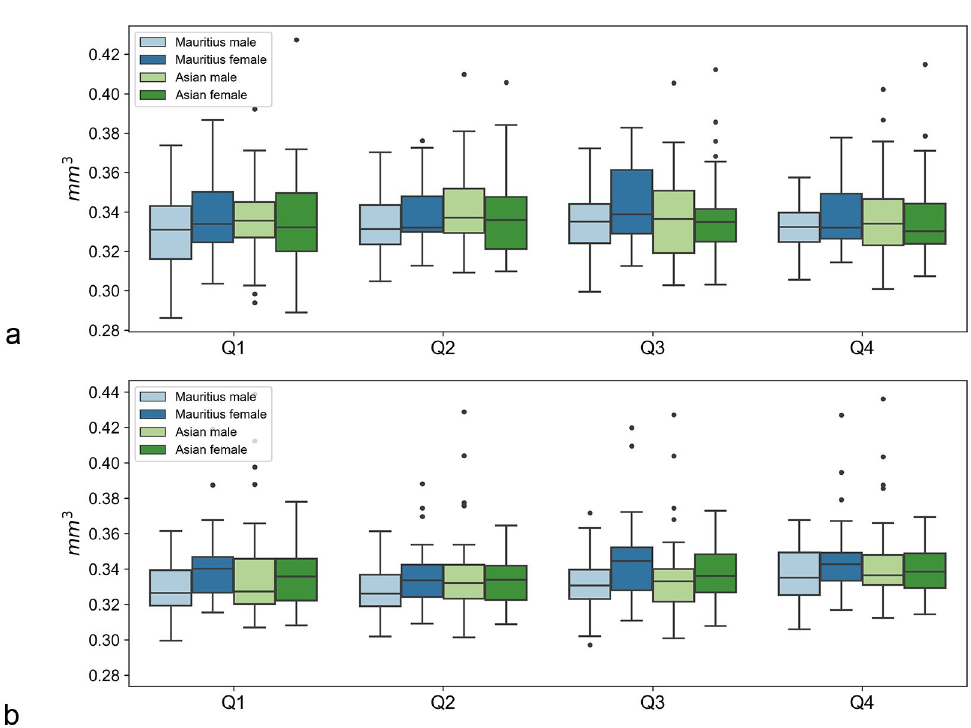
Fig 3. Boxplots of sex-specific variations in choroid volumes. For right ( 3a , OD) and left eyes ( 3b , OS) measured as